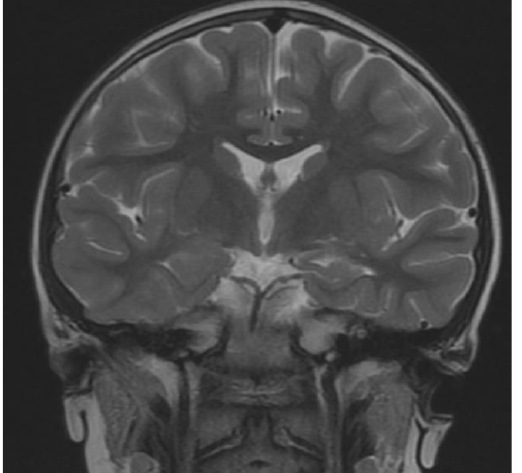
Figure 1. Coronal B (T2-weighted sequence) — Thicker cortical layer on the right side.